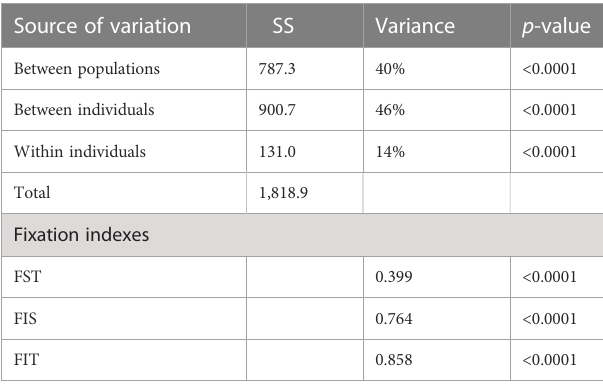
TABLE 3 Molecular analysis of variance and endogamy coef fi cients for a divided